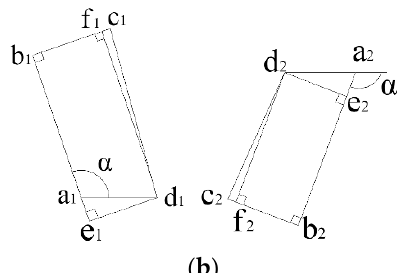
Figure 10. Schematic diagrams of the geometric relationship for adjustment cylinder. ( a ) Structure of adjustment cylinder. ( b ) Geometric relationship for adjustment cylinder. Note: l c 1 d 1 is maximum expansion of cylinder, l c 2 d 2 is the length of cylinder without expansion, x is the expansion of adjustment cylinder, l c 1 d 1 , l c 1 d 1 , lc 1 d 1 and lc 1 d 1 are auxiliary lines. The corresponding values are as follows: l ad = l a 1 d 1 = l a 2 d 2 = 200 mm, l bc = l b 1 c 1 = l b 2 c 2 = 215 mm, l ab = l a 1 b 1 = l a 2 b 2 , l c 1 d 1 = l c 2 d 2 + x , l d 1 e 1 = l b 1 f 1 , l b 1 e 1 = l d 1 f 1 , l d 2 e 2 = l b 2 f 2 , l b 2 e 2 = l d 2 f 2 .